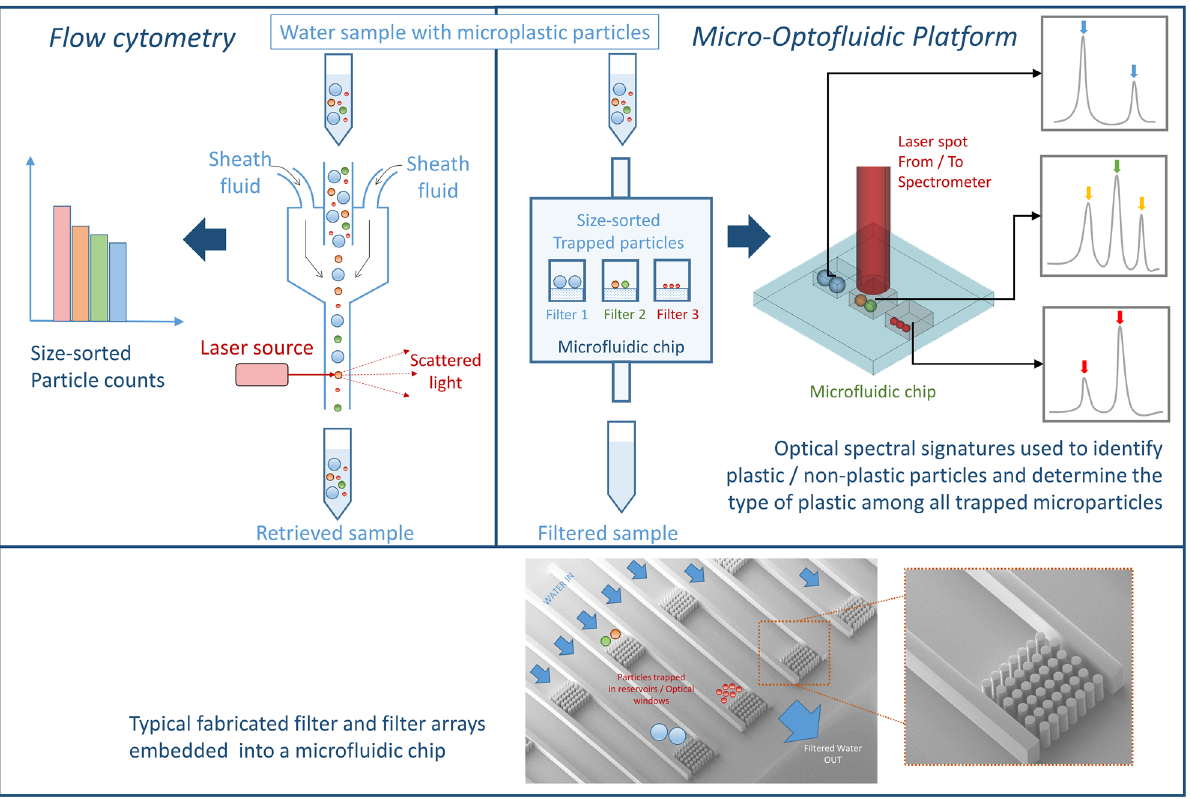
Figure 2. An illustration for the proposed analysis platform. On the left, flow cytometry is demonstrated which can be used as a reference technique to count and obtain statistics about the microparticles sizes and shapes, but the chemical nature information is lost. On the right, the proposed analysis platform is demonstrated which involves a microfluidic chip used to sort and trap the microparticles, in addition to enabling imaging and the identification of the chemical nature of the trapped particles using spectroscopic techniques. The particles are trapped in a series of reservoirs each terminated with a filter consisting of an array of